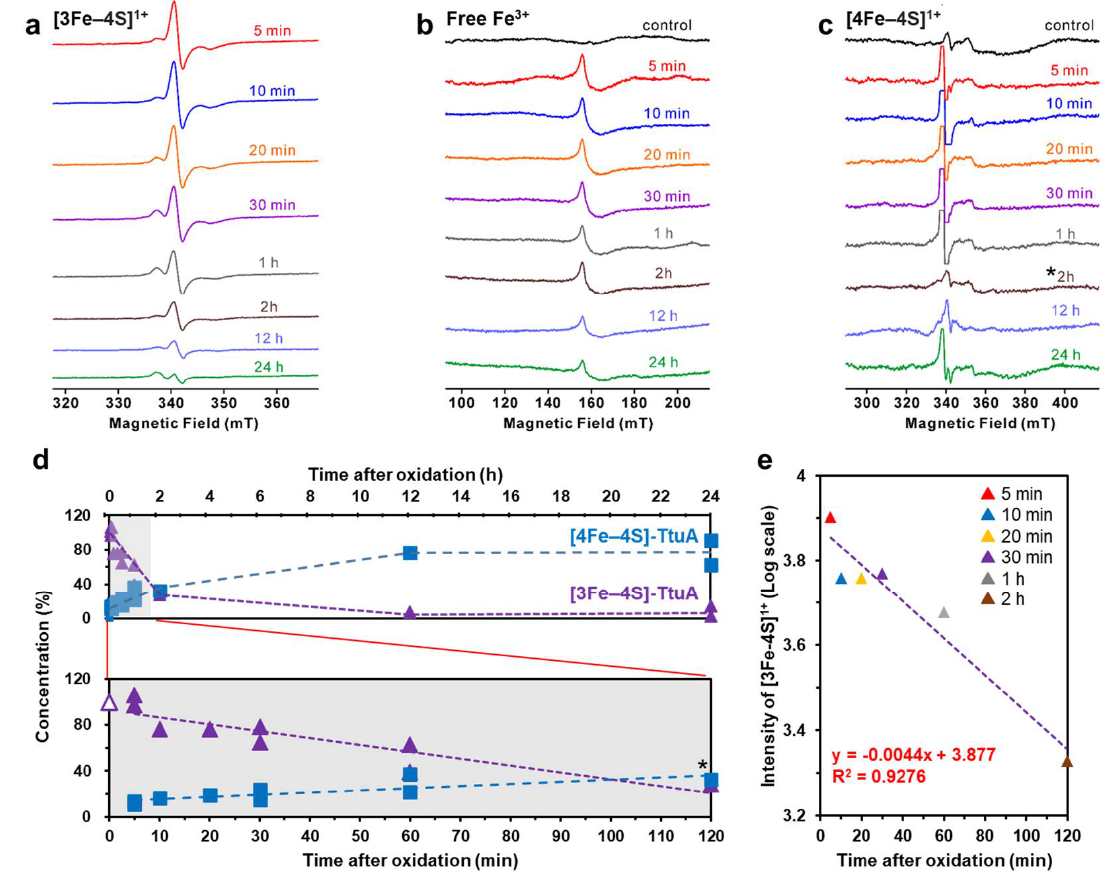
Figure 1. Structural changes in the Fe–S cluster bound to TtuA. [3Fe–4S] 1+ ( a ), free Fe 3+ ( b ), and [4Fe–4S] 1+ ( c ) EPR spectra of K 3 [Fe(CN) 6 ]-oxidized TtuA were detectable in time-course. ( d ) Top: The plot of structural changes in Fe–S clusters in time-course, which was estimated from the EPR spectra of ( a , c ). Bottom: close-up view of 0–120 min in ( d ) (top). We conducted EPR experiments twice at 5, 30, 60 min, and 24 h. Note that the amount of [3Fe–4S] immediately after oxidation (0 min) was estimated as 100% (indicated in a purple triangle) from the calibration curve because measurement at 0 min is impossible. ( e ) Calibration curve of the signal intensity of [3Fe–4S] 1+ versus time after oxidation. The color code of each point is the same as that in ( a ). Asterisks (*) in ( c , d ) indicate a weak signal with a relatively larger experiment error.